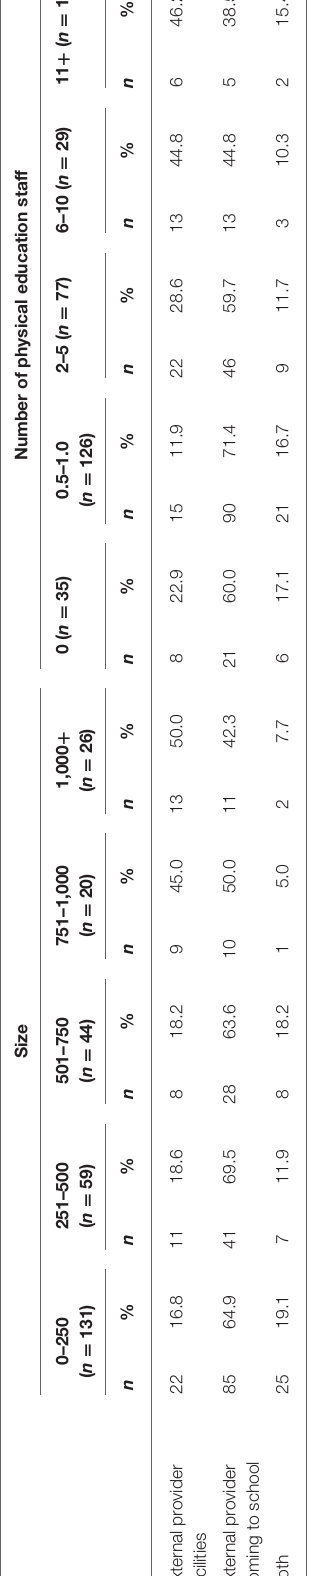
TABLE 7 | Funding of outsourced